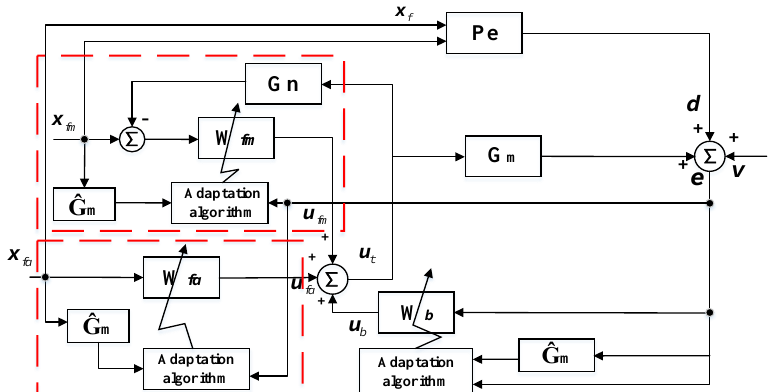
Figure 8. Block diagram of the MIMO modified simplified hybrid active noise control system (the two feedforward structures are indicated by the dashed rectangles), mainly including two reference signals vectors x fm and x fa , error signals vector e , nominal plant responses matrices G m and G n , three control filter matrices W fm , W fa and W b .